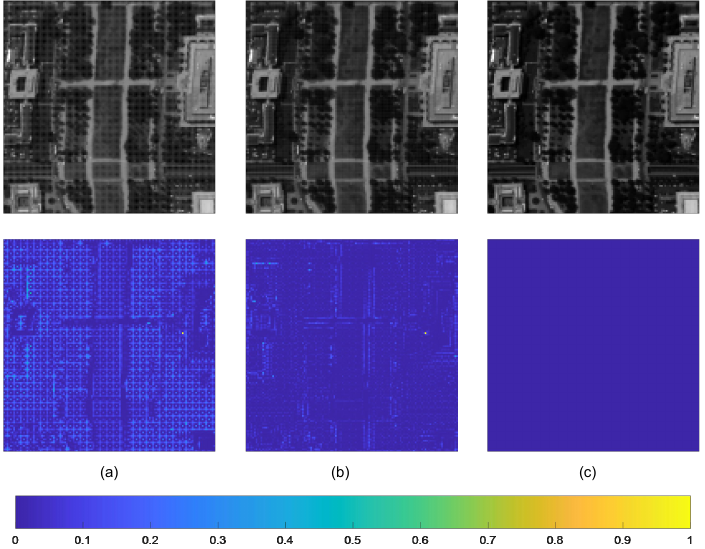
Figure 6. Reconstructed HR-HSI and its corresponding error image at the 30th band for Washington DC Mall. ( a ) HTSRWM method; ( b ) HTSR method; ( c ) Ground